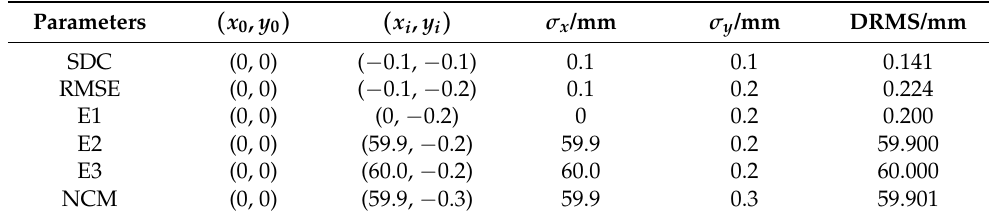
Table 4. The original DRMS of real defect and simulated